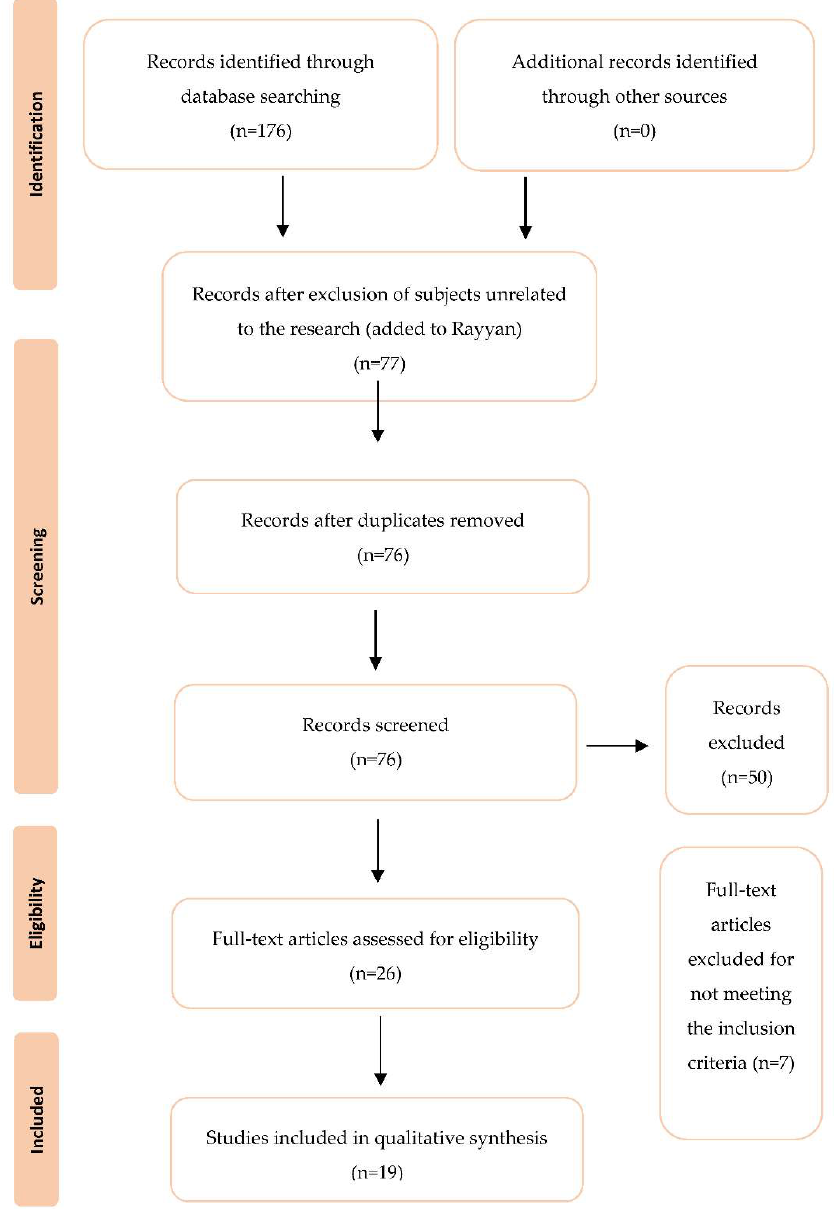
Figure 1. PRISMA based selection of articles .